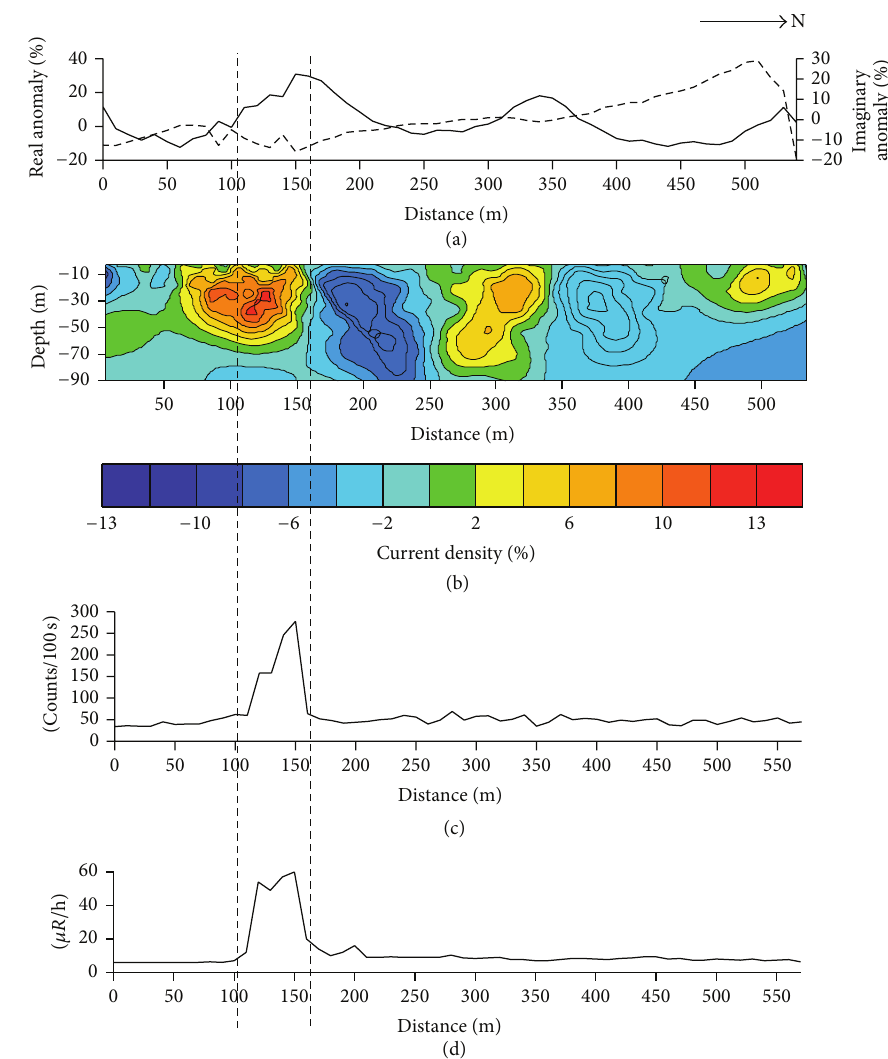
Figure 5: Profile P1400: (a) VLF anomaly (real by solid line and imaginary by dashed line), (b) pseudo current density cross-section along profile P1100, and (c) surface radiation and (d) surface gamma